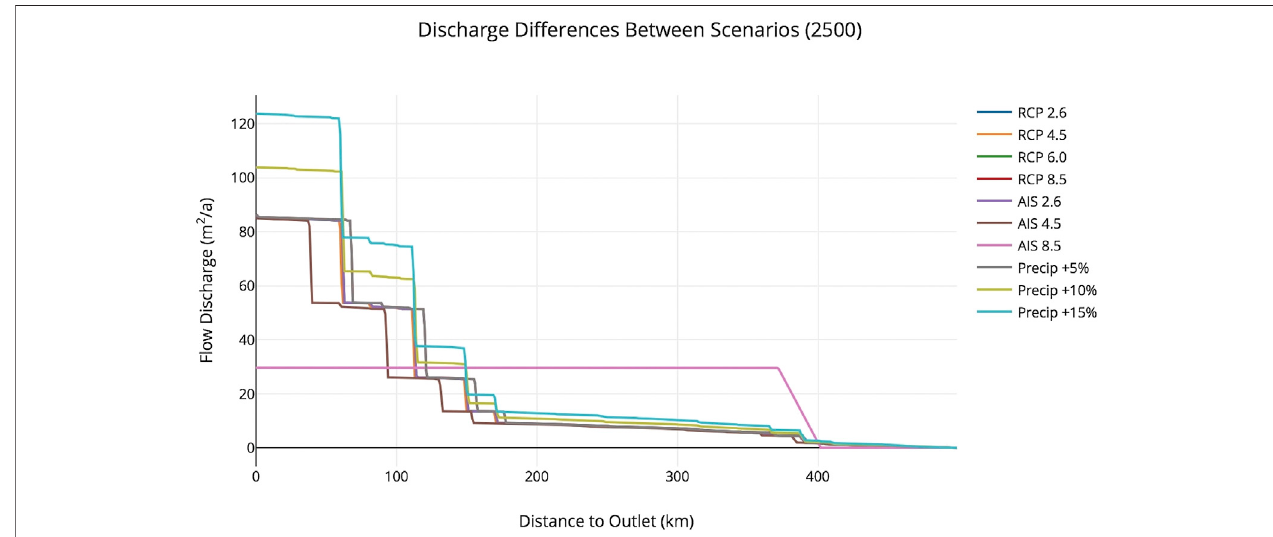
FIGURE 12 | Comparison of discharge rates within the Tweed River by 2500 between all climatic scenarios.